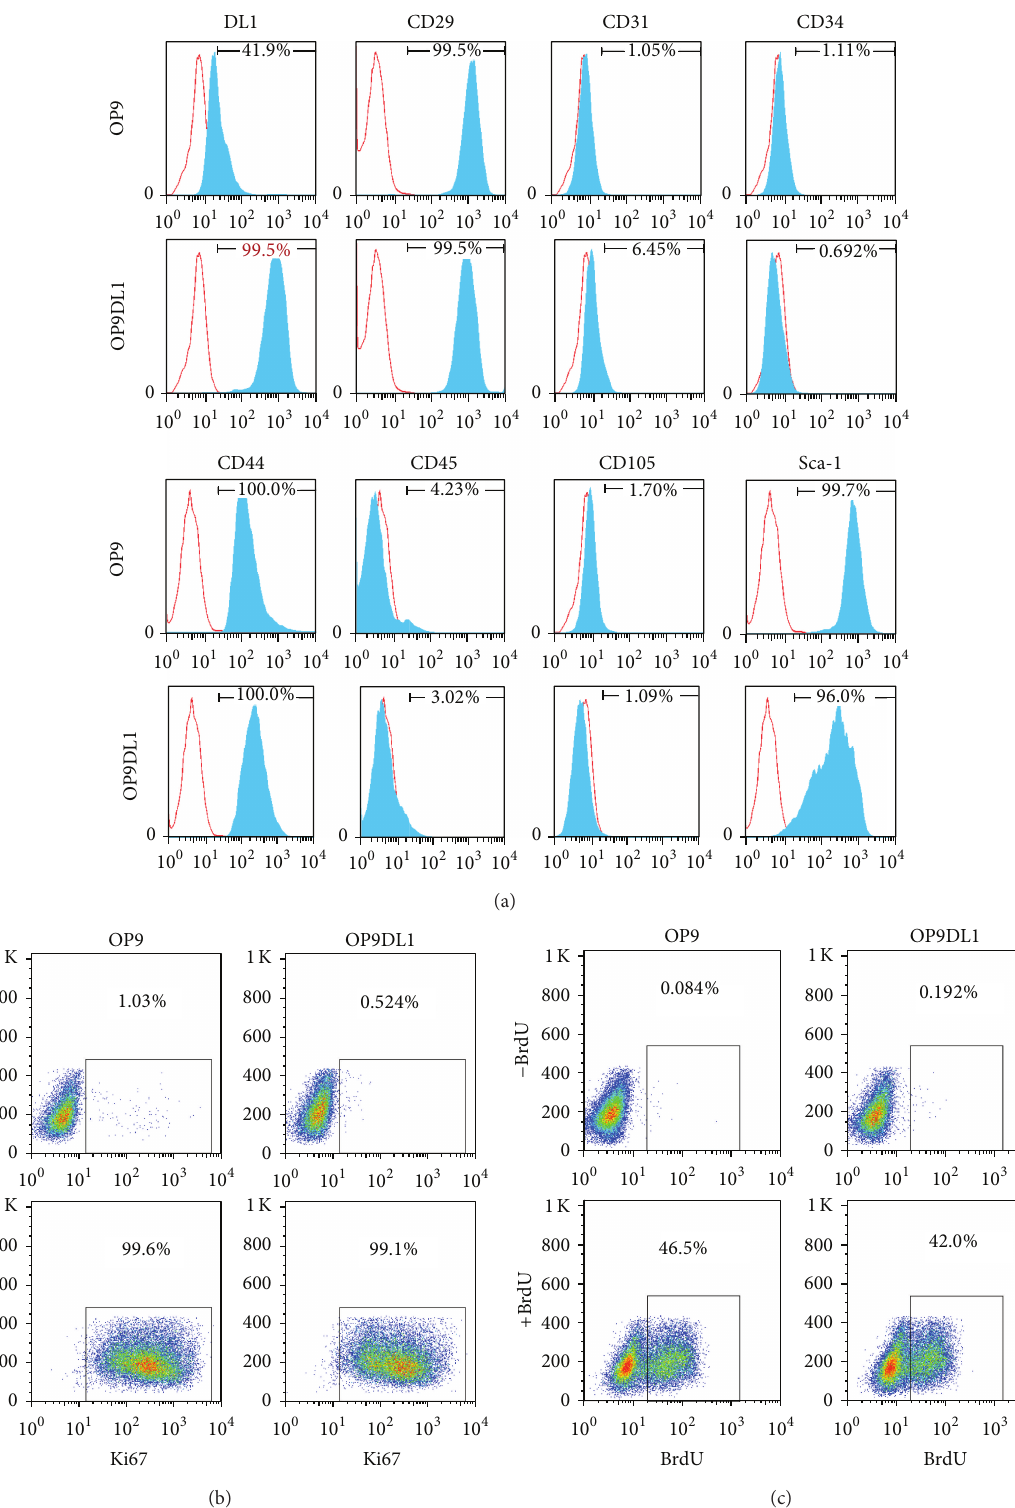
Figure 1: Comparisons between OP9 and OP9DL1 cells with regard to their immunophenotype and proliferation. (a) The indicated surface markers of OP9 or OP9DL1 cells were shown by FACS analysis, respectively. ((b)-(c)) The growth rate of OP9 and OP9DL1 cells was assayed by Ki67 or BrdU incorporation assays,